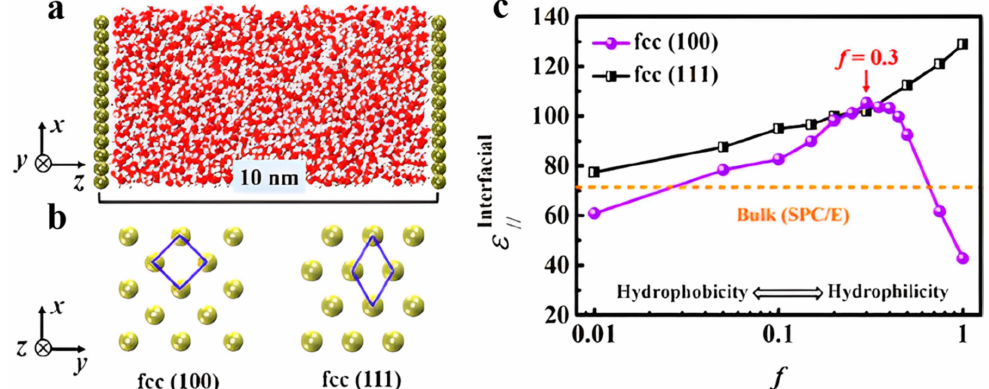
Figure 6. Anomalously low, parallel, dielectric constant of interfacial water at the fcc (100) hydrophilic surface: ( a ) schematic representation of the confined water between two fcc (100) or (111) sheets separated by a distance of 10.0 nm in the z direction. ( b ) Top view of the lattice arrangement of the fcc (100) (left) and (111) (right) surface models, and ( c ) parallel permittivity of the dielectric constant of interfacial water ε Interfacial (equal to ε xx and ε yy ) at the fcc (100) and (111) surfaces versus the (cid:107) surface-water interaction f (the orange, dashed line shows the constant for bulk water). (Reprinted from Ref. [158], Copyright 2021 American Chemical